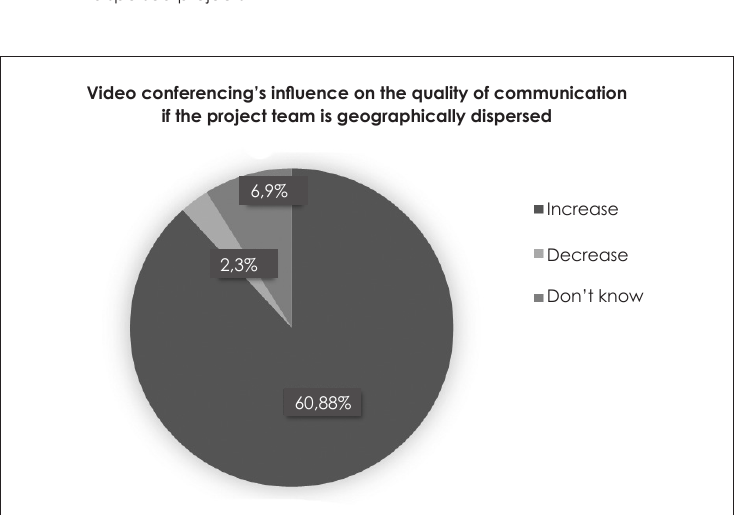
Figure 9: Influence of IM on the quality of communication in geographically dispersed projects